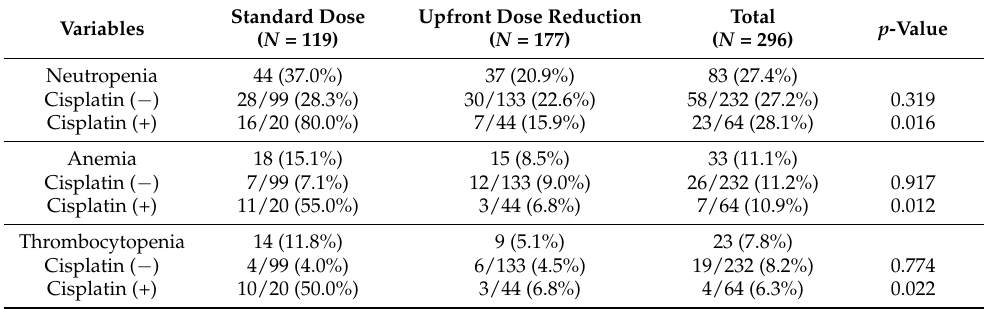
Table 5. The effect of a cisplatin-containing regimen on the hematologic adverse events (Grade 3–5).